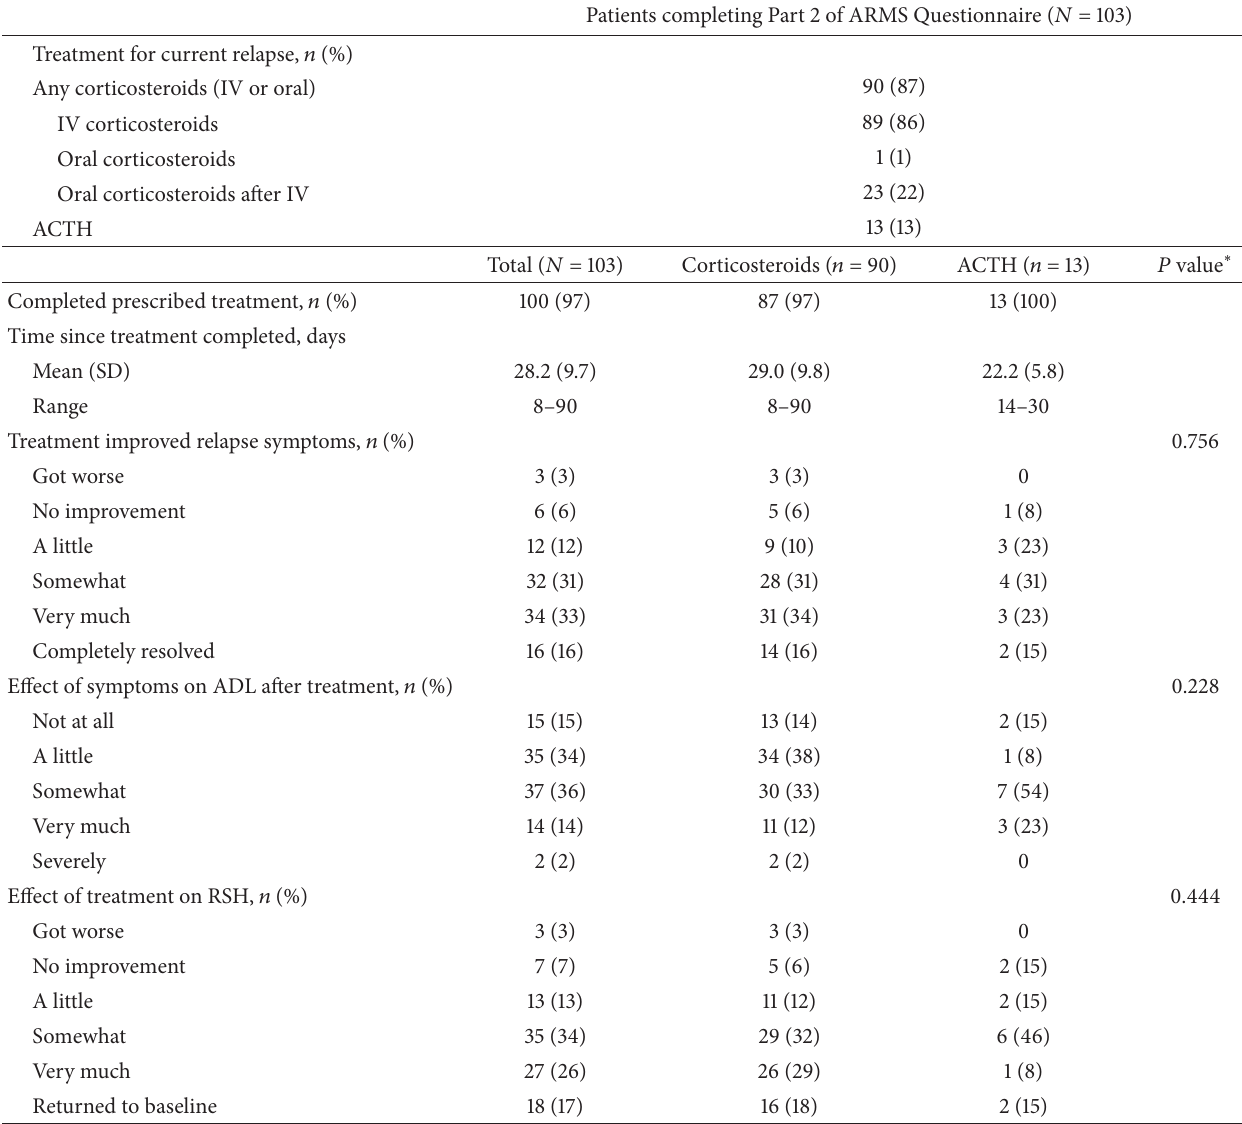
Table 4: ARMS Questionnaire Part 2—Treatment and outcomes for current